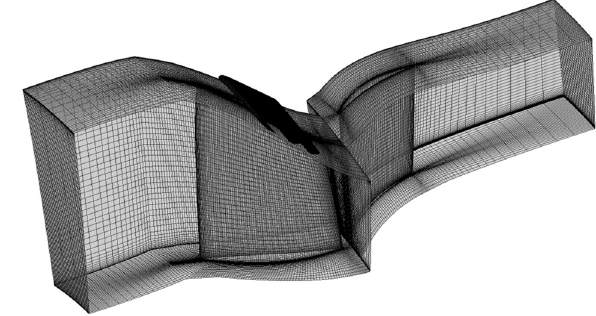
Figure 2. Computational domain and grid system.